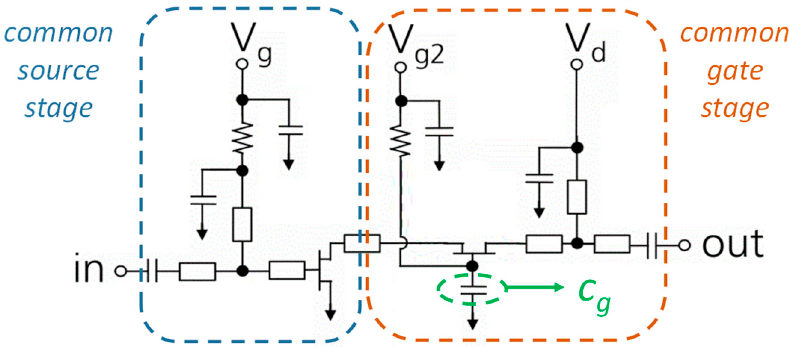
Figure 8. Schematic of a cascade mmw-LNA.